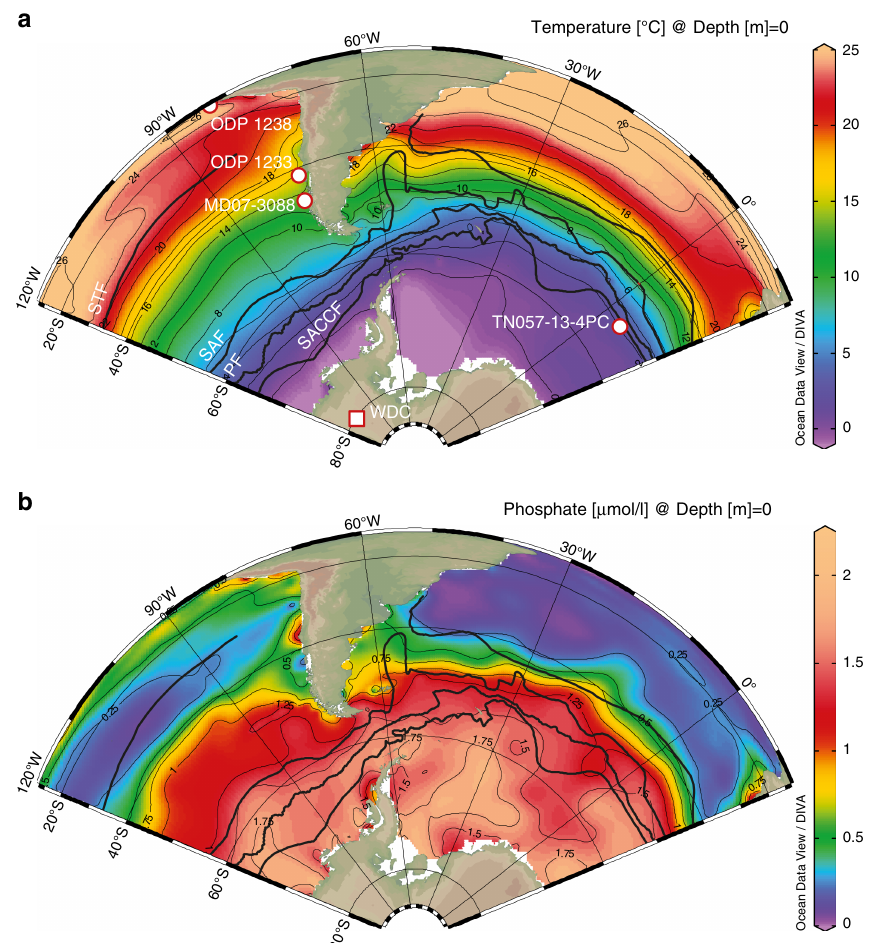
Fig. 1 Location of sites and modern ocean surface temperature and phosphate concentrations. Temperature ( a ) and phosphate ( b ) concentration fi elds are plotted with the Ocean Data View (ODV) software 68 with WOA09 69 . Solid black lines represent the: Subtropical (STF), Subantarctic (SAF), Polar (PF) and Subantarctic Circumpolar Current (SACCF) Fronts 70 . The Polar Frontal and Subantarctic Zones are the regions between the PF and SAF, and between the SAF and the STF respectively. a Solid white circles symbolize the geographic location of sediment cores MD07-3088 (46.1°S, 75.7°W, 1536m), TN057-13- 4PC 30 (53.2°S, 5.1°E, 2850 m), and sites ODP 1233 29 (41.0°S, 74.4°W, 838 m) and 1238 15 (1.5°S, 82.5°W, 2203 m). The solid white square highlights the West Antarctic Ice Sheet Divide ice core 56 (WDC, 79.5°S, 112.1°W, 1766 m above sea